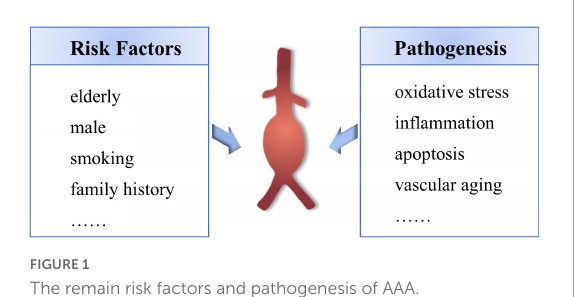
FIGURE1 The remain risk factors and pathogenesis of